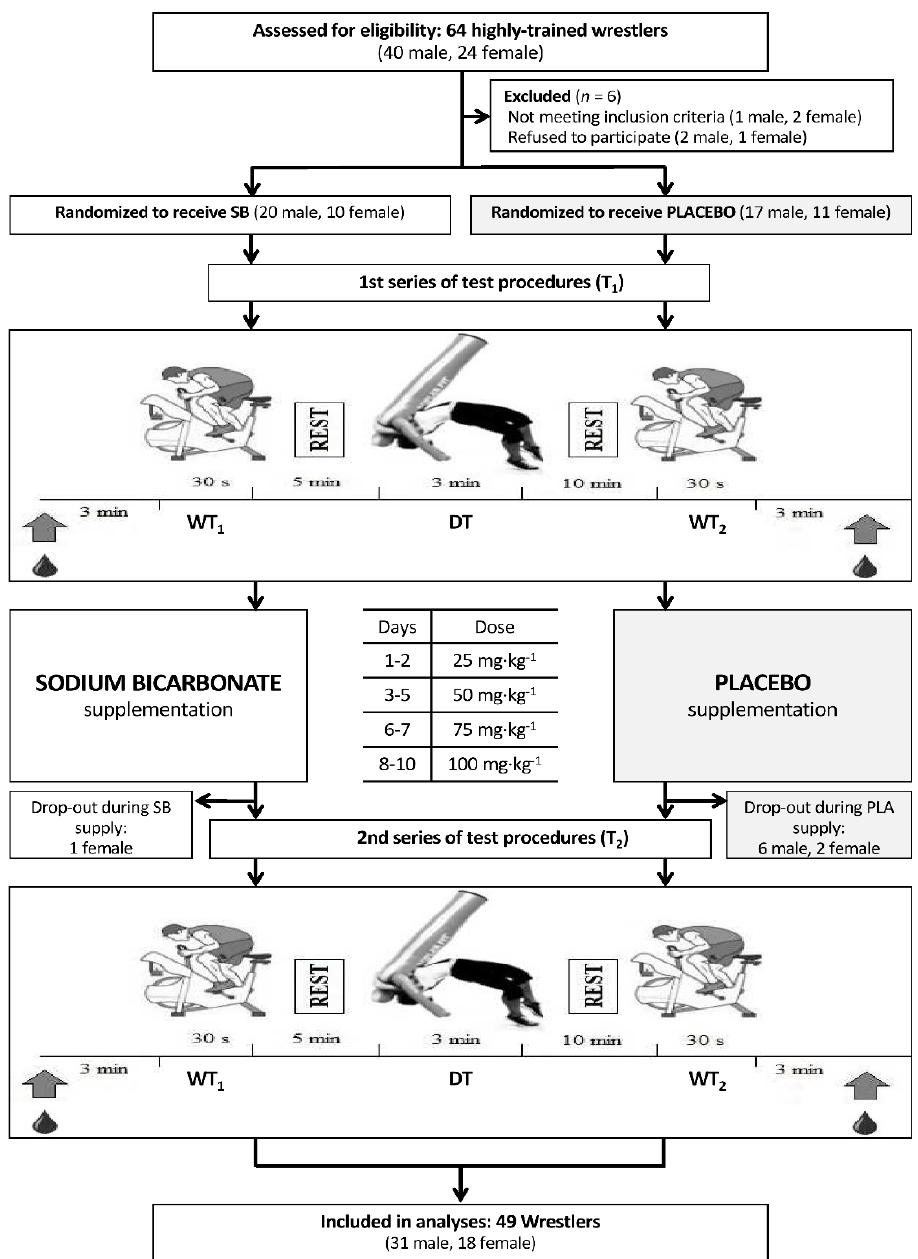
Figure 1. A flowchart of the study design. Abbreviations: T 1 —1st series of test procedures, T 2 —2nd series of test procedures, REST—the rest interval between exercise sets, PLA—placebo, SB—sodium bicarbonate, WT 1 —the Wingate test before the dummy throw test, WT 2 —the Wingate test after the dummy throw test, DT—the dummy throw test.